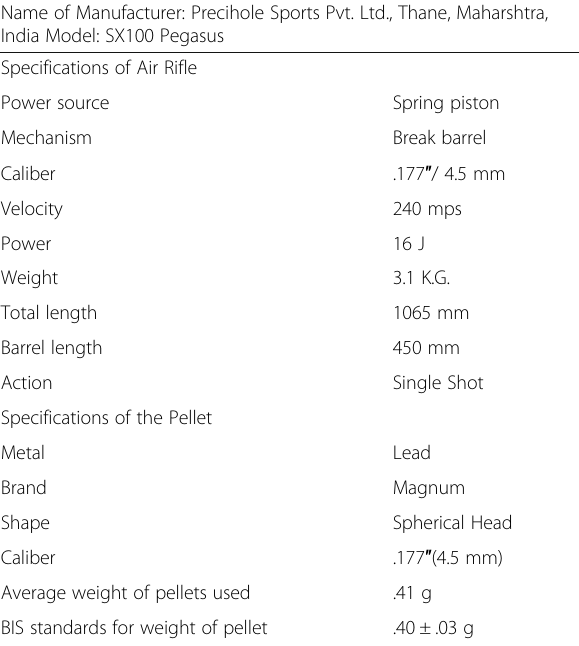
Table 1 Specifications of the weapon and the pellet